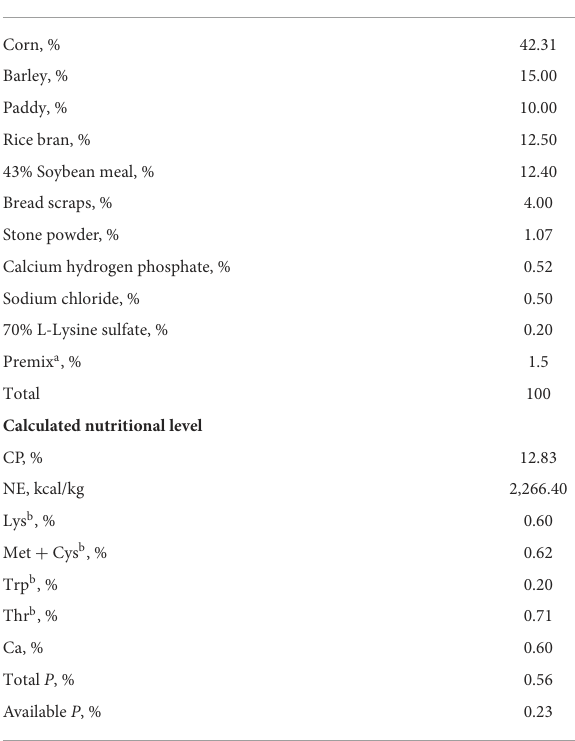
TABLE 2 Effects of diet supplementation with niacin on growth performance of Ningxiang pigs a